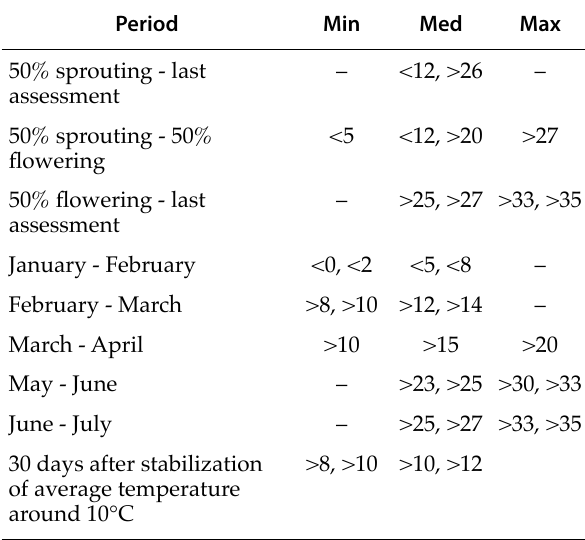
Table 2. Minimum (Min), average (Med) and maximum (Max) temperatures (°C) considered to obtain number of days below (<) or above (>) the indicated value in different